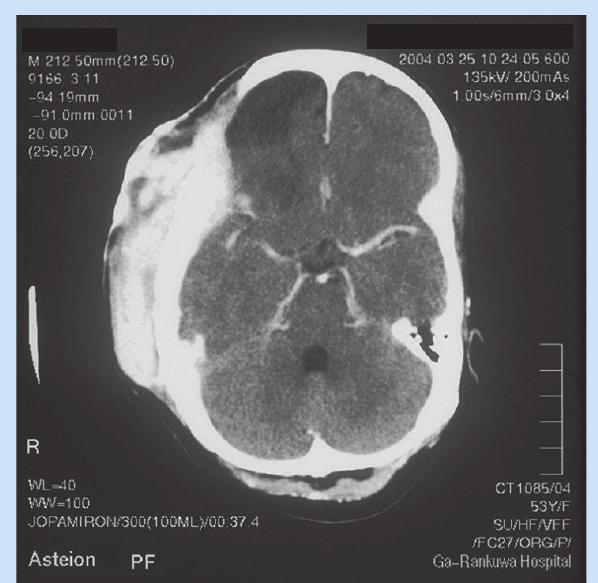
Fig. 3. Post-contrast axial CT scan: dense homogeneous enhancement of both the extra-and intracranial components of the